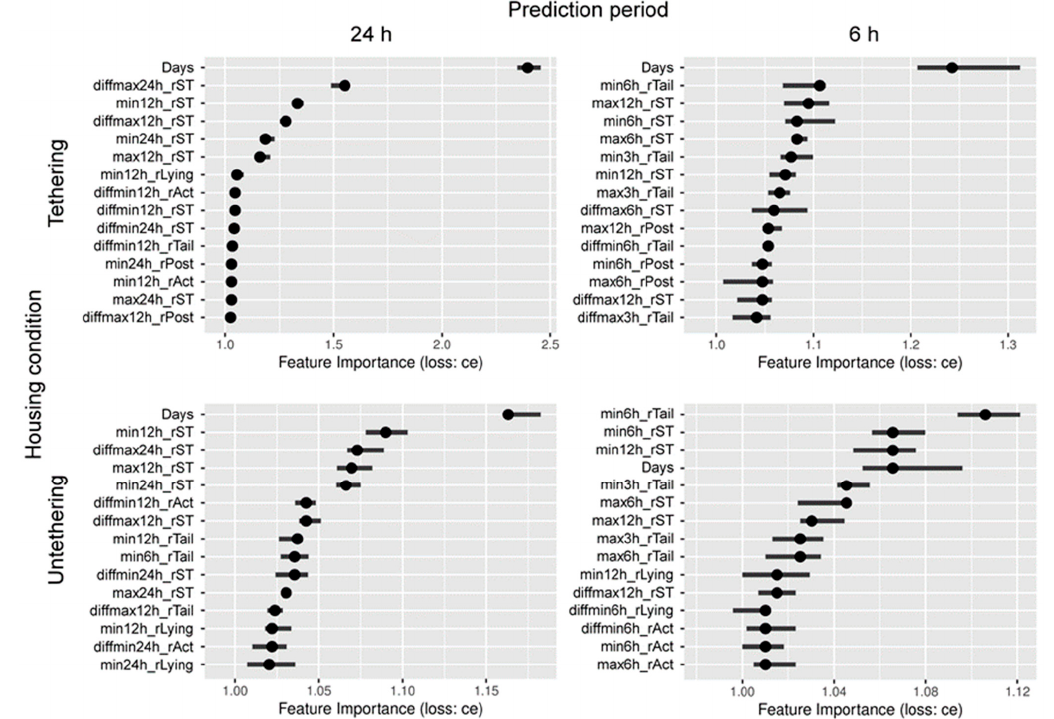
Figure 3. Permutation feature importance for predicting 24-h and 6-h periods before calving under tethering and untethering housing conditions (15 most important features out of 41 features used). Classification error loss function (loss: ce) was used to calculate the relative importance of each feature. Black circles denote median importance, and the horizontal lines denote the 90%-quantile of importance values. Abbreviations indicate as follows: Days, days to the expected calving date; minXh, minimum value during the last X h (X = 3, 6, 12, or 24); maxXh, maximum value during the last X h; diffminXh, difference between the current value and minimum value during the last X h; diffmaxXh, difference between the current value and maximum value during the last X h; rST, residual skin temperature; rAct, ratio of activity intensity; rLying, ratio of lying time; rPost, ratio of posture change; rTail, ratio of tail raising index.